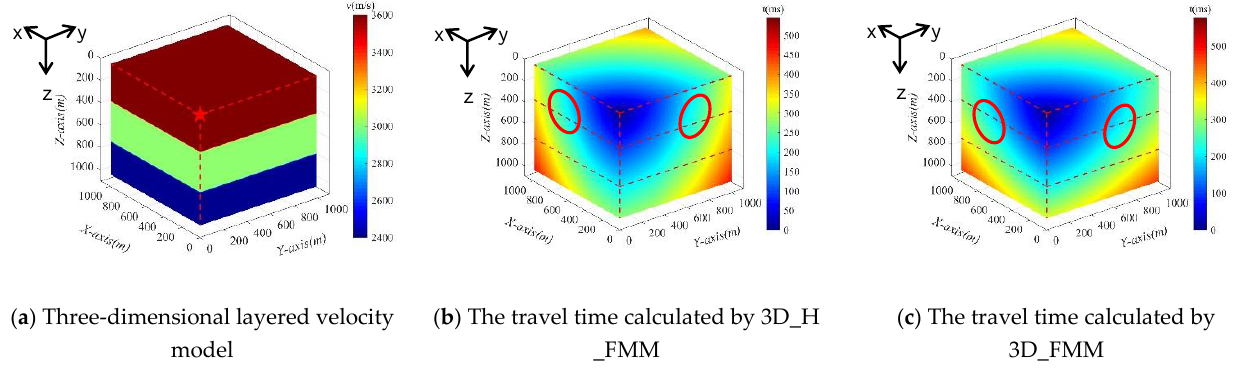
Figure 11. The Case D: large-scaled inhomogeneous velocity model and the travel time calculated by 3D_H_FMM and 3D_FMM.